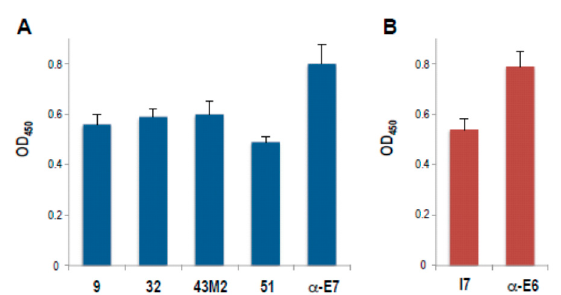
Figure 1. Characterization of the anti-16E7 and anti-16E6 scFvs reactivity against the respective recombinant oncoproteins by ELISA. Data represent the mean ± SD of samples in quadruplicate from a representative experiment of three with similar results. ( A ) the anti-16E7 scFv9 (9), scFv32 (32), scFv43M2 (43M2), scFv51 (51) and ( B ) the anti-16E6 scFvI7 (I7) are indicated. Anti-16E7 polyclonal Ab and anti-16E6 mAb were used as positive controls .